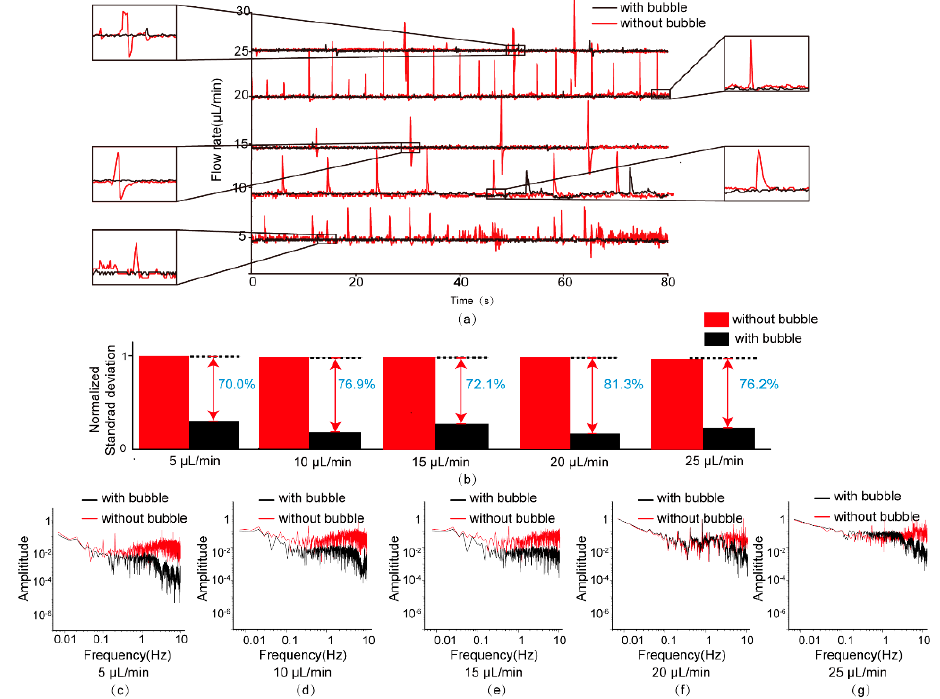
Figure 5. Characterization of flowrate fluctuation output using the syringe pumping set-up with/without bubbles. ( a ) The flowrate profiles produced by the stabilizer under different flowrates of 5 μ L/min, 10 μ L/min, 15 μ L/min, 20 μ L/min, and 25 μ L/min. ( b ) Comparison of the normalized standard deviation of the syringe pumping flowrate with/without bubbles under different flowrates. ( c – g ) The spectrum analysis of the flowrate profiles produced by the stabilizer under different flowrates of 5 µ L / min, 10 µ L / min, 15 µ L / min, 20 µ L / min, and 25 µ L /